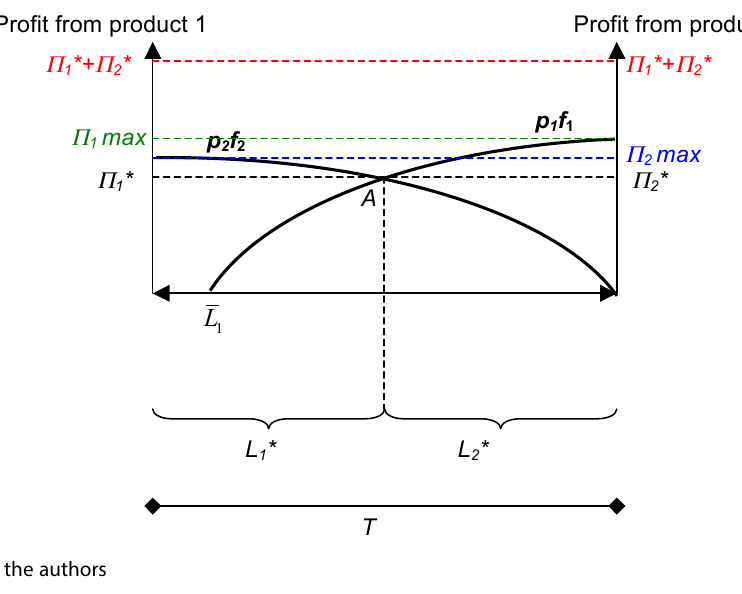
Figure 1. Graphical representation of labour allocation for a full-time